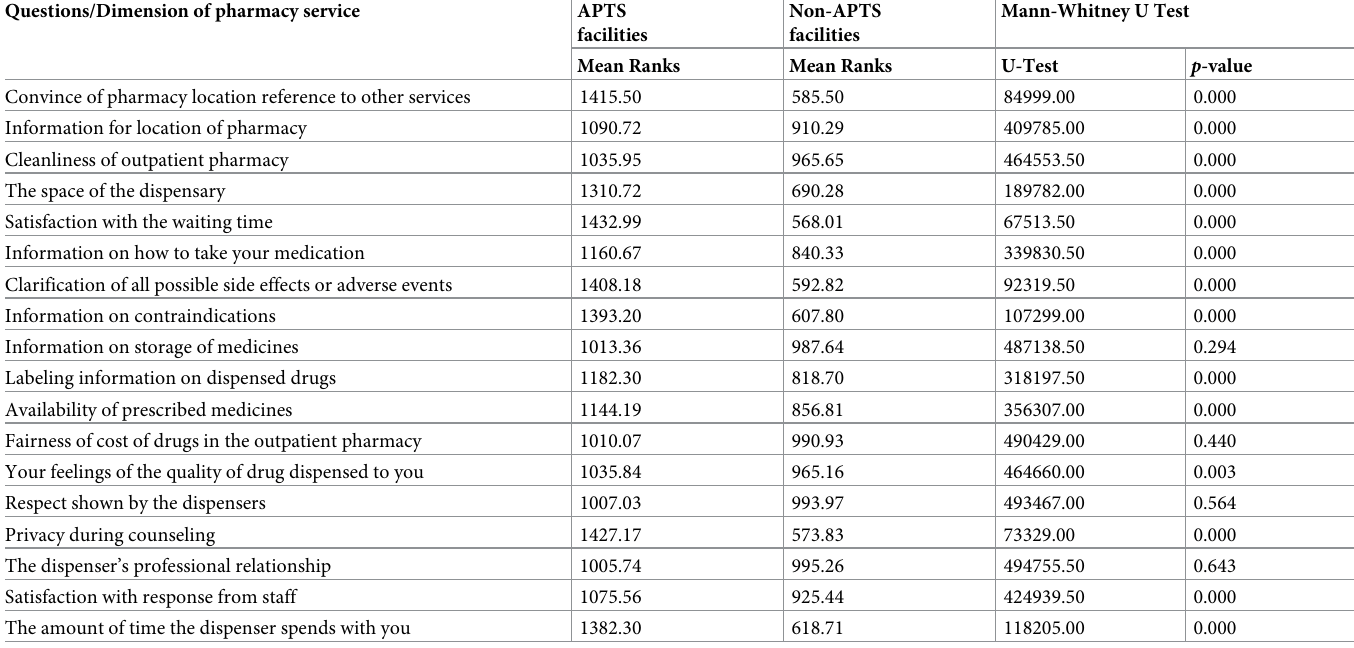
Table 6. Patient satisfaction score between facilities participating in APTS and Non-APTS.